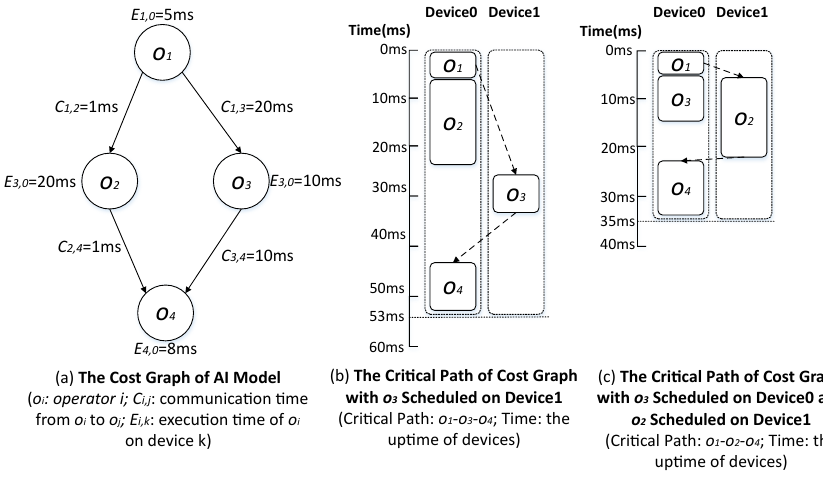
Figure 3. Critical Path